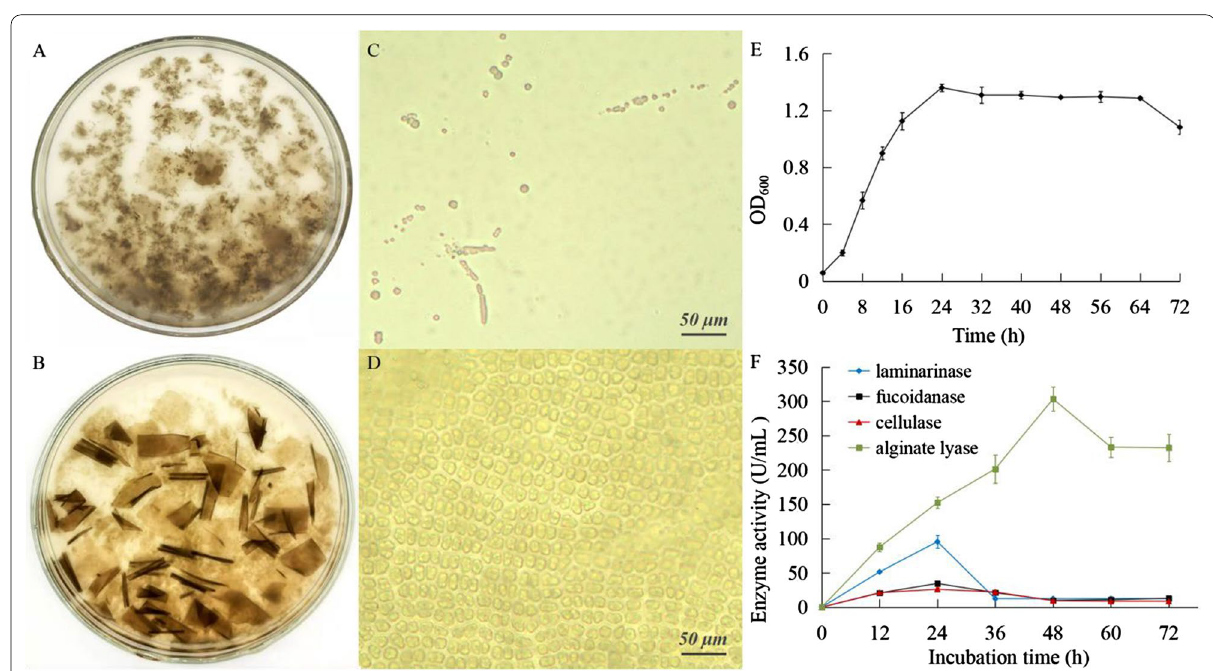
Fig. 1 Degradation of kelp ( Laminaria japonica ) thallus fragments and polysaccharide substrates by strain ALW1 in kelp medium. A Kelp inoculated with the ALW1 cells. B Uninoculated kelp. C Micrograph of kelp cells inoculated with ALW1 strain and incubated at 30 ℃ at 80 rotation speed for 72 h, and kelp cells dispersed in the medium. D Micrograph of kelp cells in the culture medium without ALW1 strain and incubated at 30 ℃ with stirring at 80 rpm for 72 h, and the kelp cells were still neatly arranged. E Growth of strain ALW1 in L. japonica medium at 30 °C with stirring at 80 rpm for 72 h. F Extracellular polysaccharide-degrading enzymes’ activities. Enzyme activity analysis included alginate lyase, laminarinase, fucoidanase and cellulase assays. All the above enzyme activities were measured after ALW1 strain was inoculated in kelp medium and incubated at 30 ℃ with stirring at 80 rpm for 72 h. Data are presented as mean SD from three independent ±